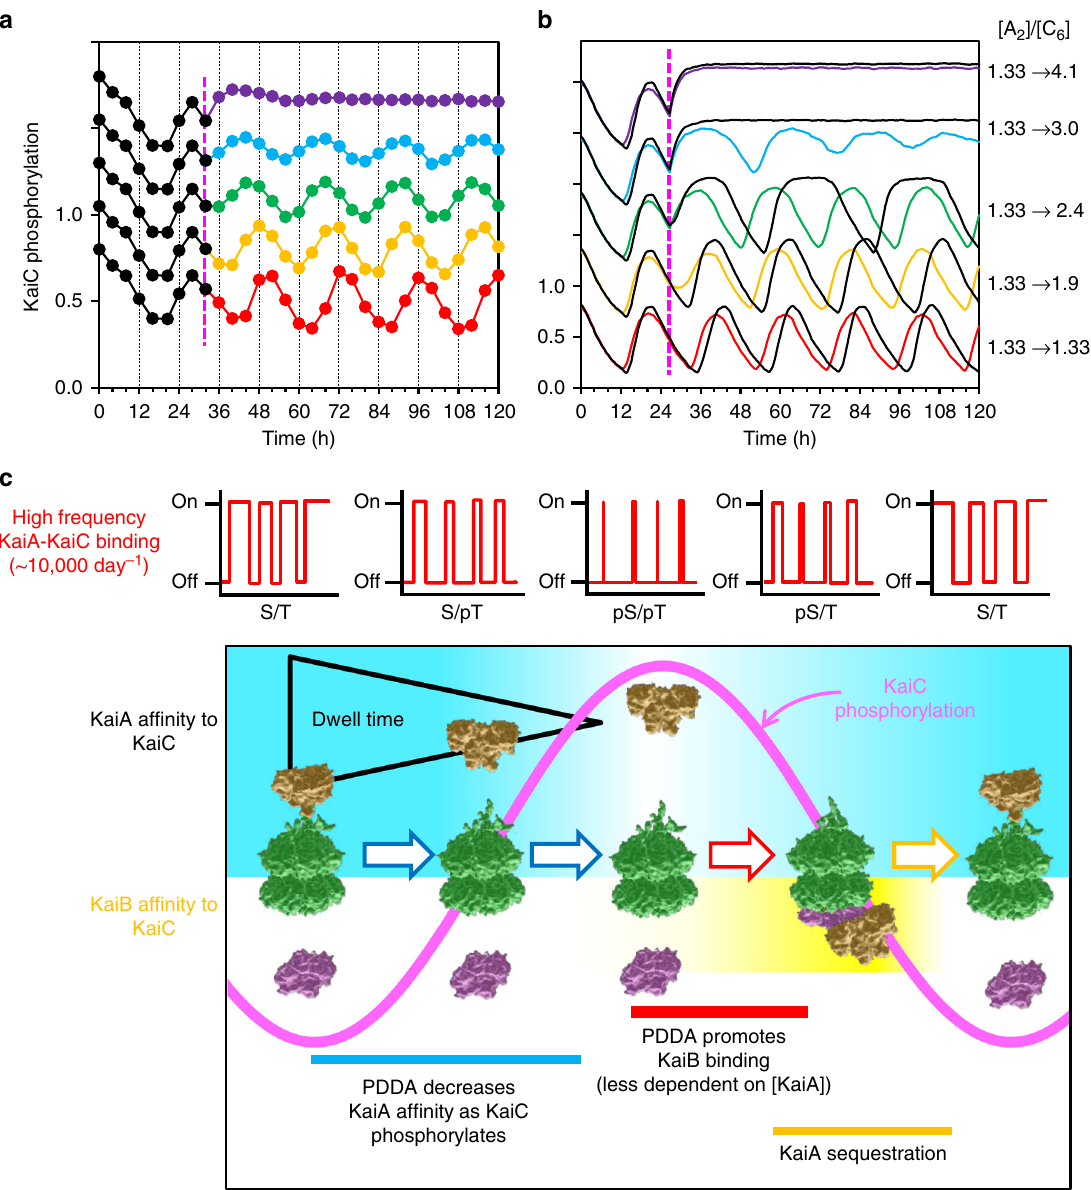
Fig. 7 In silico and in vitro tests of PDDA enhancement of resilience. a Experimental con fi rmation of the simulation ’ s prediction of the effects of an acute KaiA concentration increase during the in vitro oscillation. KaiA concentrations were augmented at hour 32 by the addition of a concentrated KaiA solution to a KaiABC cycling reaction. The traces are vertically offset for clarity. The ordinal scale for each trace is the same as for the control reaction (bottom trace, black/red). b Simulation of predictions for the experimental test in a , where the ratio of KaiA dimer to KaiC hexamer ([A 2 ]:[C 6 ]) was increased from 1.33 to 1.9, 2.4, 3.0 or 4.1 at hour 27. Depicted are KaiC phosphorylation patterns resulting from KaiA steps during the dephosphorylation phase with PDDA ( + PDDA, colored traces) as compared to the absence of PDDA ( − PDDA, black traces). The [A 2 ]/[C 6 ] values at the far right apply to the experimental data ( a ) and the simulations ( b ). The traces are vertically offset for clarity as in a . c Model of PDDA ’ s action. During the phosphorylation phase of KaiC (S/ T → S/pT → pS/pT), PDDA causes KaiA af fi nity for KaiC to decrease progressively, resulting in a shorter dwell time. Therefore, KaiC phosphostatus feeds back upon KaiA/KaiC interaction, changing the pattern of high-frequency KaiA/KaiC binding events and slowing its own rate of phosphoryation. This affects the k D of KaiA-stimulated KaiC phosphorylation, thereby in fl uencing the period of the oscillation during the phosphorylation half-cycle. Moreover, PDDA facilitates the pS/pT → pS/T transition (by reducing the pS/T → pS/pT back reaction), enhancing KaiB association and the entry into the dephosphorylation half-cycle. This makes the overall oscillating reaction less sensitive to KaiA:KaiC stoichiometry and thus more resilient to fl uctuations of the concentrations of the Kai proteins. KaiC, green; KaiA, gold; KaiB,